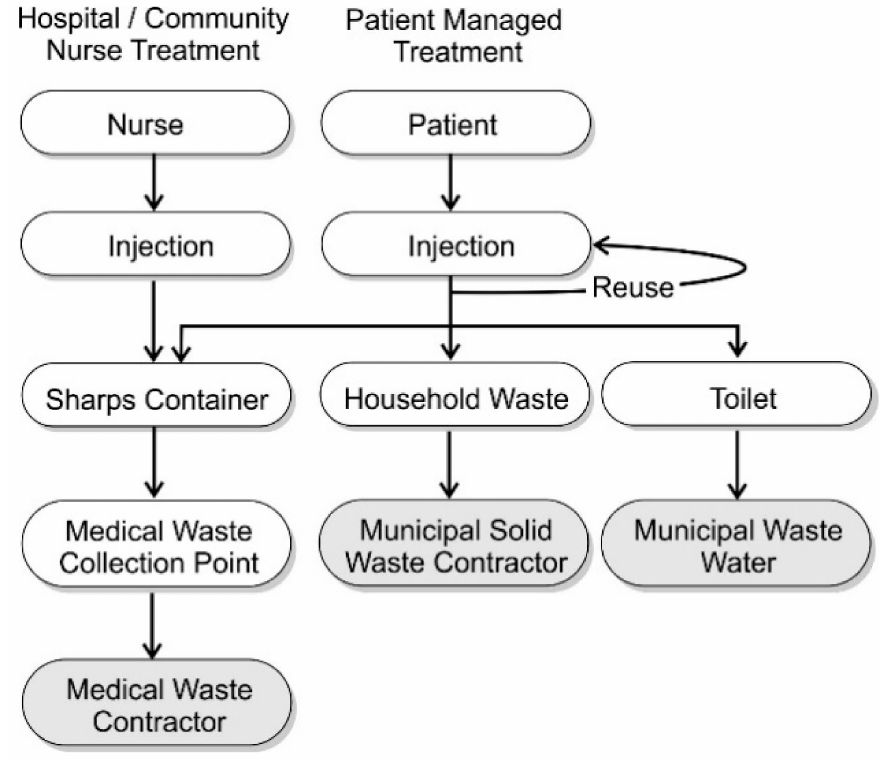
Figure 2. Sharps disposal practices for healthcare worker- and patient-managed treatment